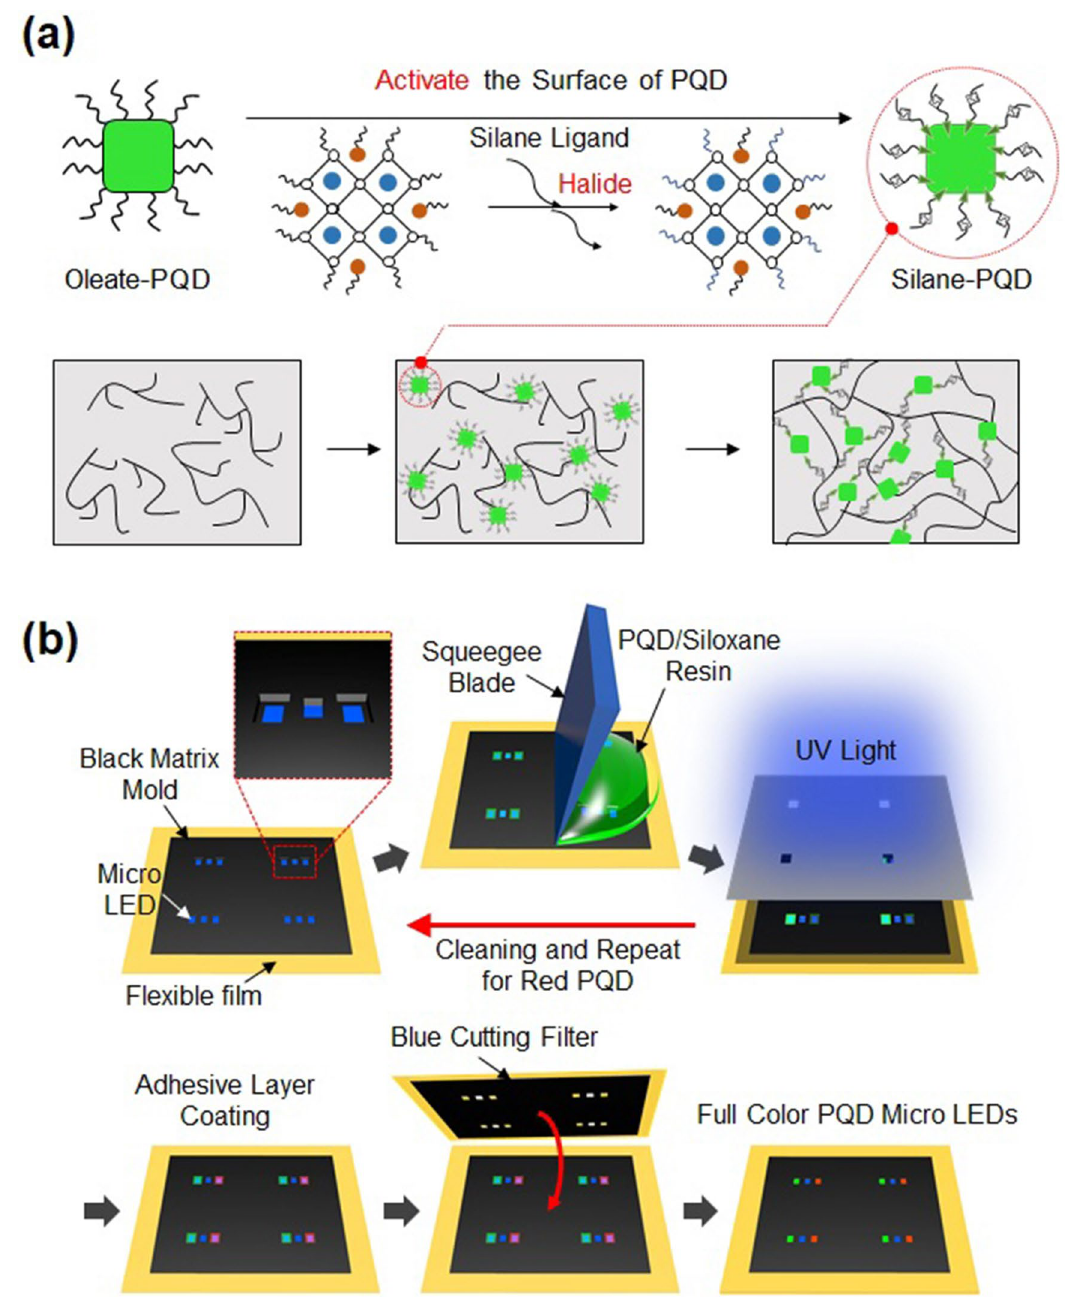
Figure 1. Schematic illustration of ( a ) ligand exchange of oleate-capped perovskite quantum dots (PQDs) with silane-capped PQDs and ( b ) fabrication procedure for full-color micro-LEDs with PQD/siloxane composite as color conversion